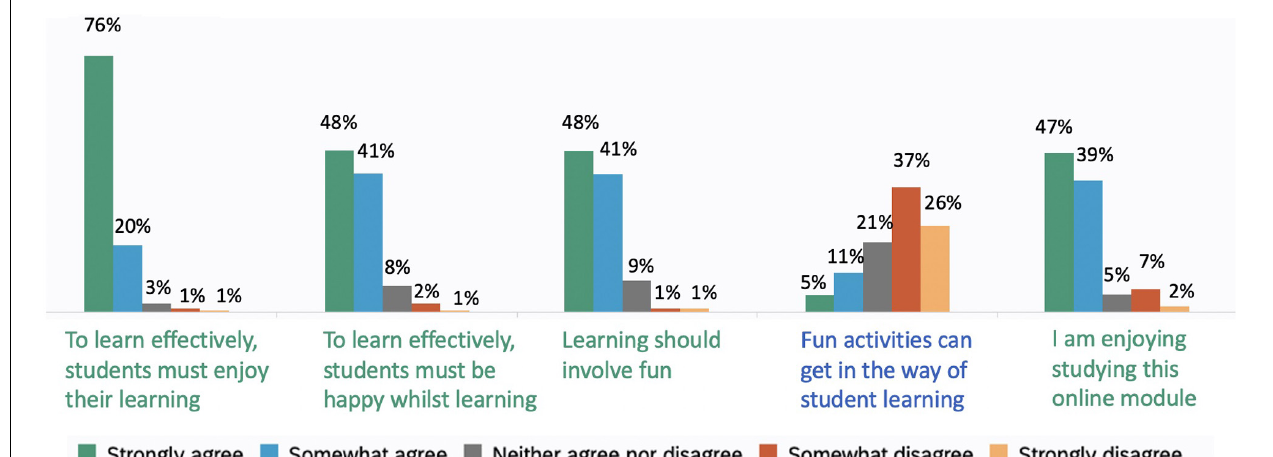
In addition, the graphical comparison between recommendations and full set of qualitative data both auto coded ( Figure 3 ) in NVivo 24 ( Graph 2 ) ensured diversity with a variety